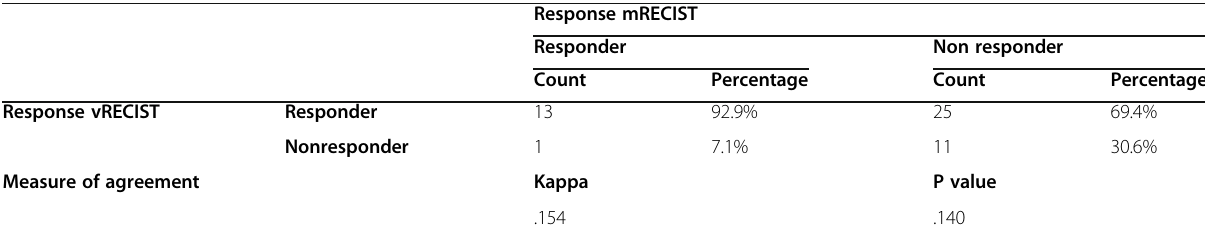
Table 5 Relation between mRECIST and vRECIST methods in assessment of the therapeutic response whether responders or non-